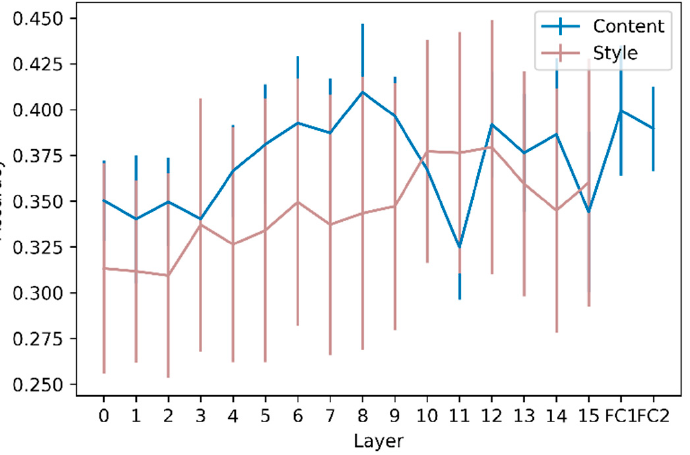
Figure 5. Accuracy of the models based on the Gram matrices (in brown) and on the RGB feature maps (in blue) for each layer. The vertical bars represent the standard deviations. The highest accuracy for Gram matrices classification is 37.9% for the 13th layer.